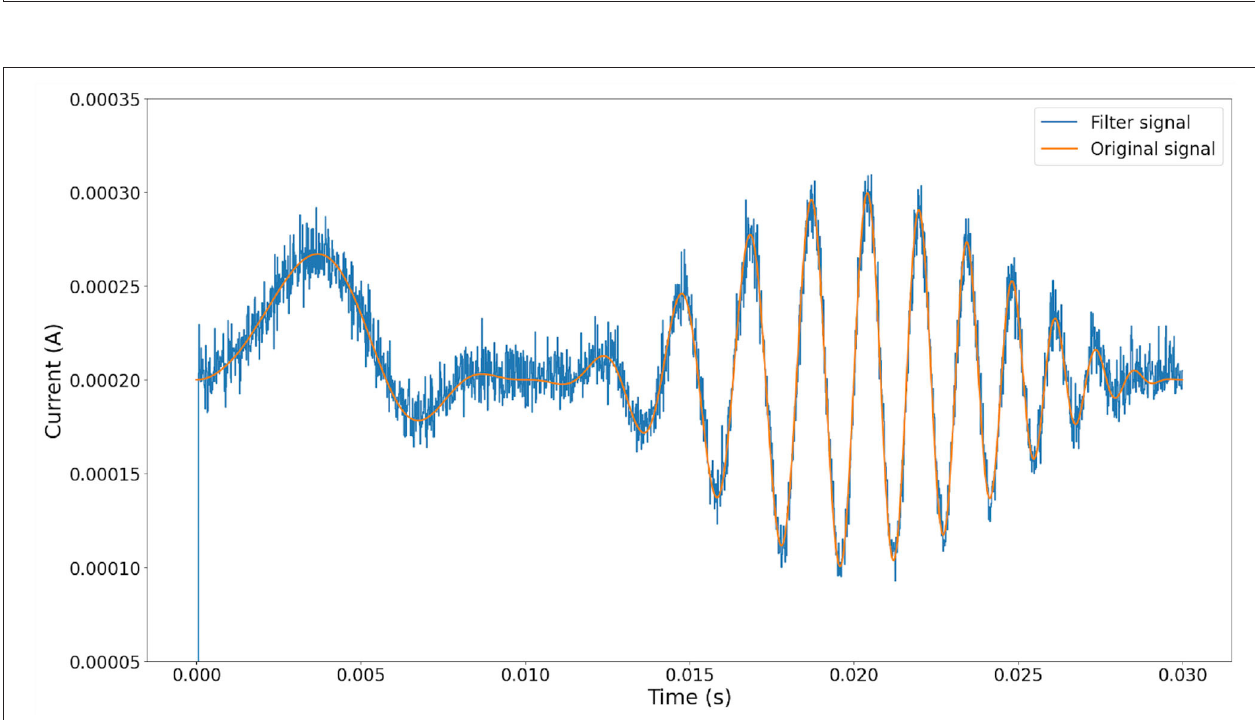
FIGURE 7 | Comparison between the original signal with the noisy signal. For this experiment, the signal was computed evaluating the function sin (1500 t 2 ) cos (50 t ) + 200 × 10 − 6 . It is important to observe that the signal must be positive at any moment.